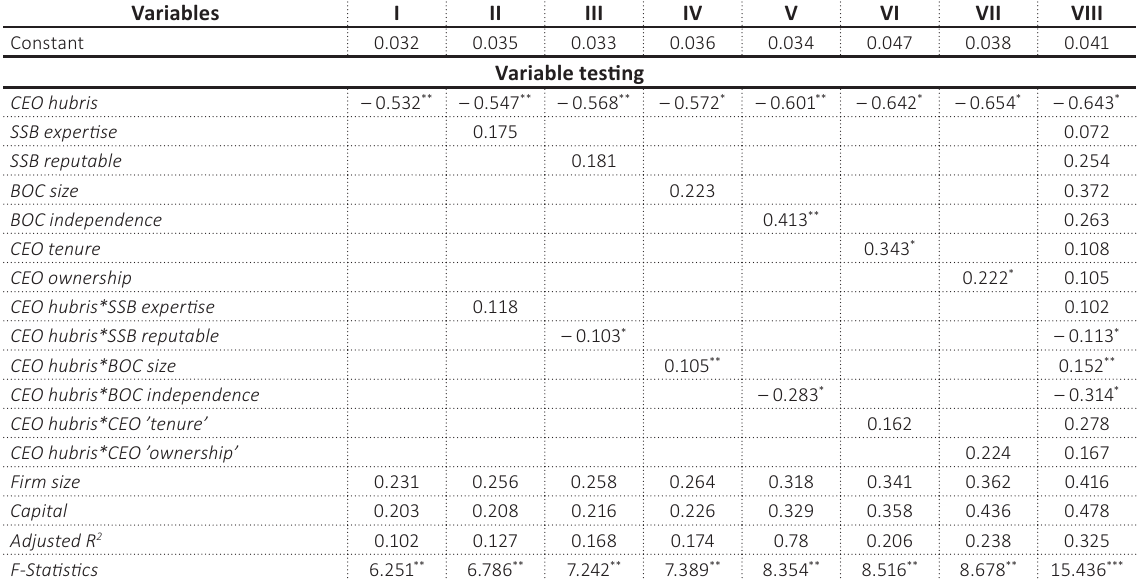
Table 6. GLS regression with the analysis of the random impact for IBs’ performance